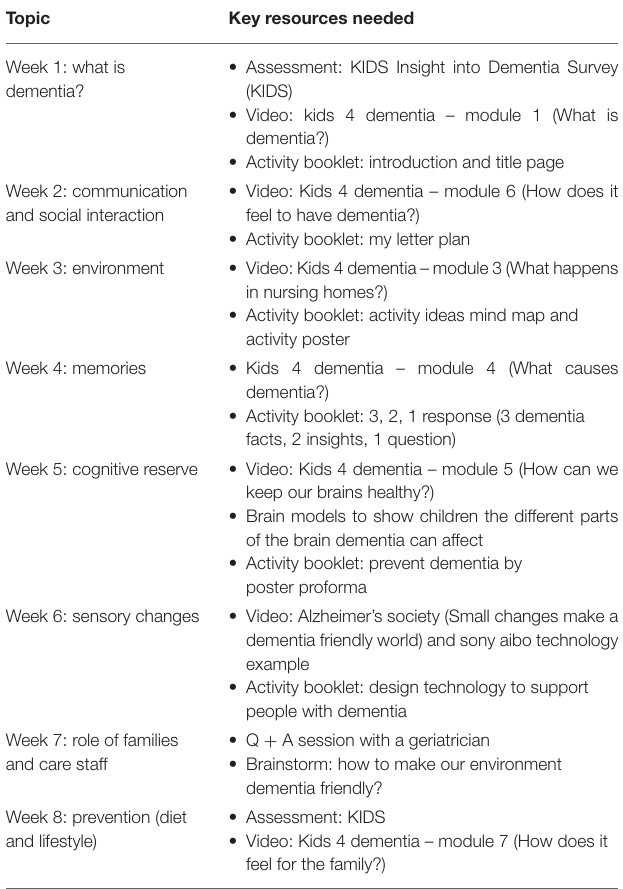
TABLE 1 | Outline of the weekly topics discussed as part of the school-based dementia education program. Topic Key resources needed Week 1: what is